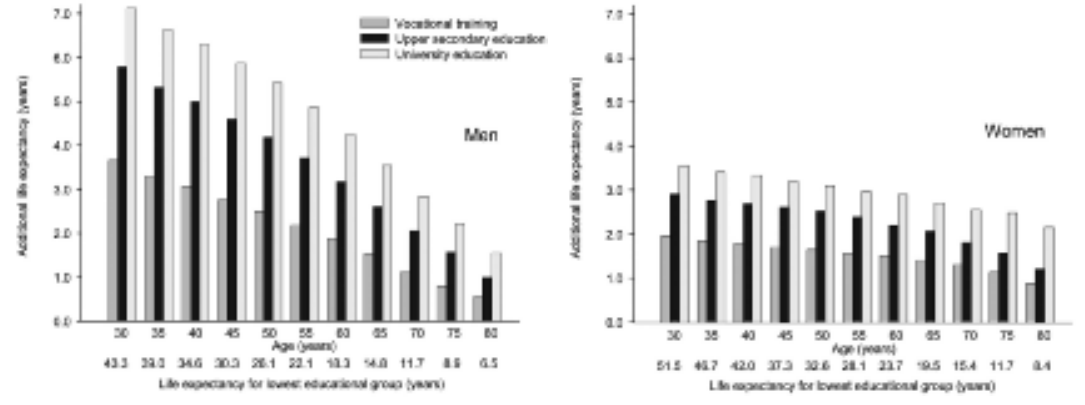
Figure 1 Life expectancy by education and gen- der in Switzerland 1990–1997: differ- ences in years between lowest and three higher